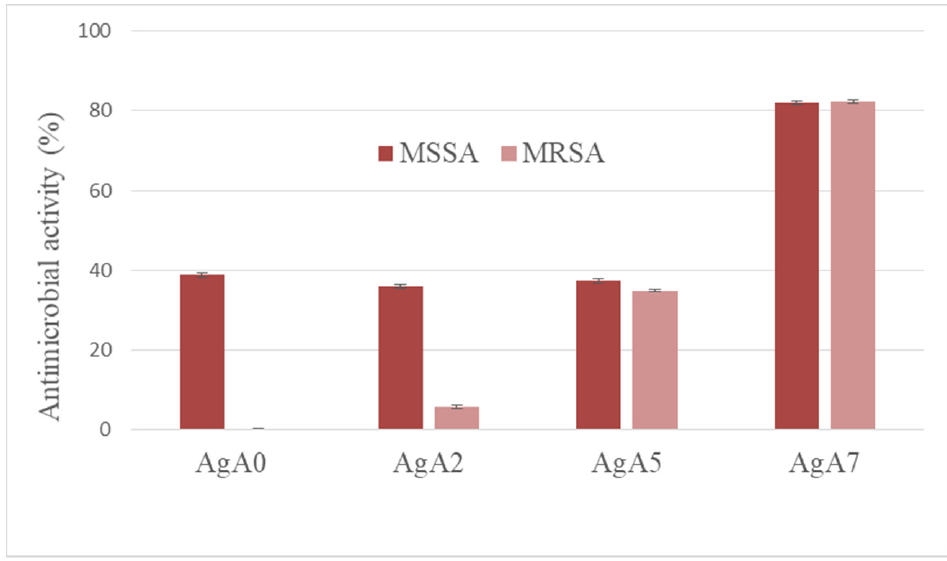
Figure 3. Antimicrobial activity of silver(I) ions in poly(acrylate/itaconic acid) matrices in contact with methicillin sensitive (MSSA) and methicillin resistant Staphylococcus aureus (MRSA). Antimicrobial activity of CuA0 and CuA7 hydrogel matrices were tested for three strains: Gram-positive bacteria S. aureus , Gram-negative bacteria E. coli , and fungus C. albicans , and monitored for 72 h. The data obtained (Figure 4) indicated the strong antimicrobial activity of the hydrogels loaded with Cu 2+ ions. The inhibition of microbial growth was near 100% for all three strains: Gram-positive bacteria S. aureus , Gram-negative bacteria E. coli , and fungus C. albicans . Even the microbial reduction was high, a slight decrease in antimicrobial activity was noticed with regards to the selected time points of Cu 2+ release. The maximum was detected after the first hour and the minimum for 72 h, owing to the quantity of residual copper, which interacts with microbial cells. From the obtained data, it follows that, by adjusting the content of IA in hydrogels, and thus the incorporated copper ions, antimicrobial activity can be precisely projected. Antimicrobial copper(II)/poly(acrylate/itaconic acid) hydrogels showed antimicrobial activity for 72 h. Microbes are killed quickly when they come in contact with various forms of copper, and copper ions released from the surface are said to play an important role in the killing process. In research studies, it was shown that many microbial species, such as E.coli , S. aureus , Salmonella enterica , Campylobacter jejuni , Clostridium difficile , Listeria monocytogenes , and Mycobacterium tuberculosis , are efficiently killed on copper or copper alloy surfaces [45]. Zinc(II) ions were loaded in poly(2-hydroxyethyl acrylate/itaconic acid) hydrogel ma- trices (tags ZnA0–ZnA7). Zinc ions bind to the COO − groups of itaconic acid in a buffer pH of 7.40, and the zinc ions’ content rose as the IA content increased [32]. Antimicrobial activ- ity for E. coli microbe was monitored for 72 h. The data obtained showed that the inhibition of E. coli growth reached almost 100% when the microbial strains were exposed to all tested Zn(II)/poly(2-hydroxyethyl acrylate/itaconic acid) hydrogels (Figure 5). With regards to the selected time points, the antimicrobial activity decreased. Therefore, it can be said that the maximum microbial inhibition capacity of hydrogels was at the beginning of the release process, and the lowest was at the end of the release study. This behavior is related to the activity of residual zinc in hydrogels after the release started. The obtained results indicated that by adjusting the content of IA in hydrogels, and thus the incorporated zinc ions, an- timicrobial activity can be modulated. Antimicrobial zinc(II)/poly(acrylate/itaconic acid) showed antimicrobial activities for 72 h during the release process. Antimicrobial action can be explained by the positively charged zinc ions attacking the negatively charged cell walls of bacteria, which leads to cell wall leakage and the death of the bacteria